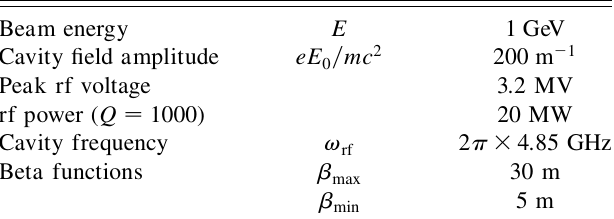
FIG. 9. (Color) Results of simulation of TM tioner. Correlation between energy and horizontal action after conditioning. The emittance growth is